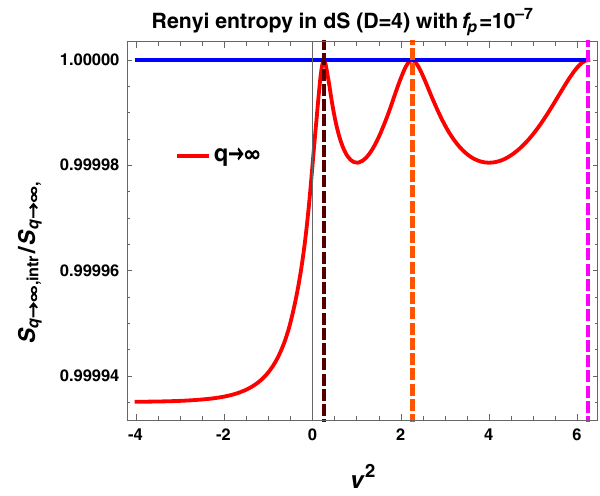
( a ) Normalized R´ e nyi entropy vs ν 2 in 3+1 D de Sitter space without axionic source ( f p = 0). Fig. 10 Normalised Rényi entropy S intr / S ν = 1 / 2 vs. mass parameter ν 2 in 3 + 1 D de Sitter space in the absence of the axionic source ( f p = 0) and in the presence of the axionic source ( f p = 10 − 7 ) for q → ∞ with ‘ + ’ branch of solution of | γ p | and | (cid:17) p , n | , which signifies largest